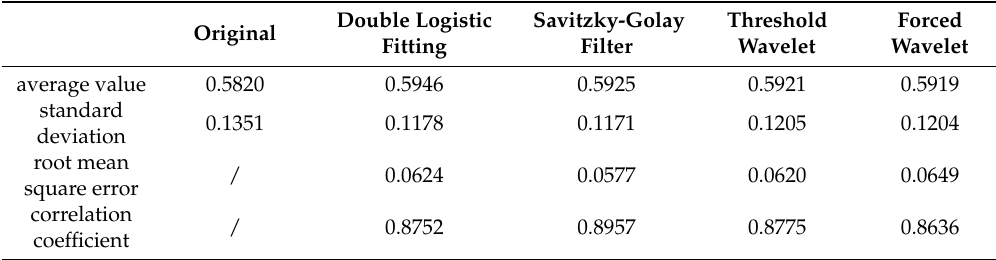
Figure 5. The fitting curves of three de-noising methods: ( a ) double logistic fitting, ( b ) Savitzky-Golay (S-G) filter, and ( c ) threshold wavelet transform. Table 4. The comparison of three de-noising methods using average value, standard deviation, root mean square error (RMSE), and correlation coefficient.